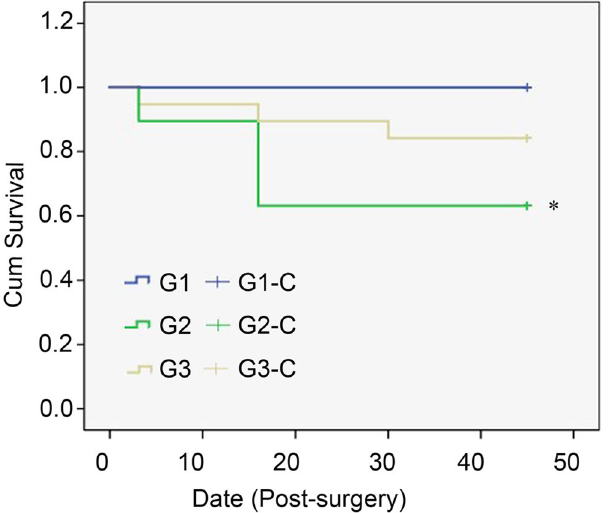
Figure 1. Survival curves for the sham-operated group (G1), the MI model (G2) and BMSC-treated MI group